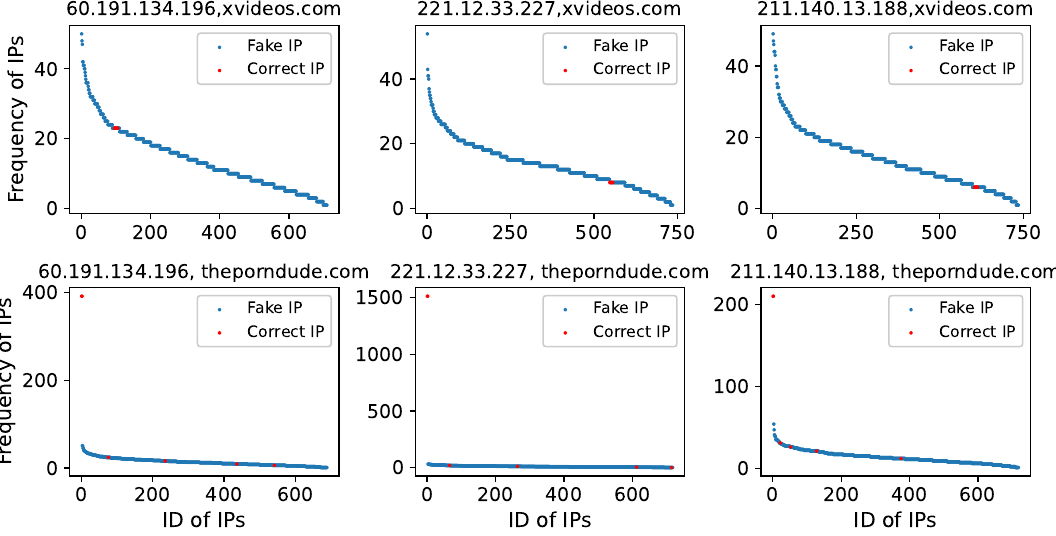
Figure 20. The frequency with which iDNS respond to correct and forged IPs for the domain theporndude.com and